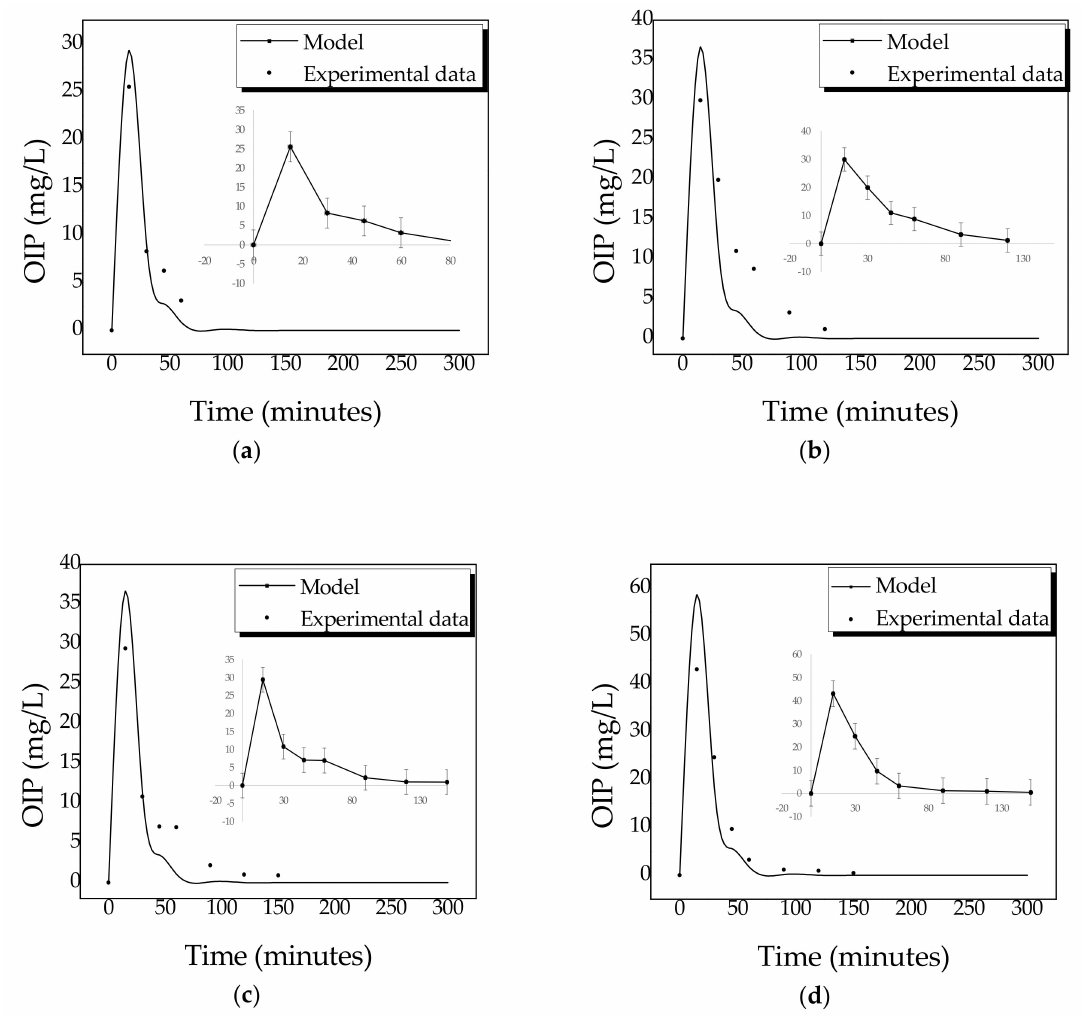
Figure 7. Profile of the generation and consumption of OIPs showing the curve generated by the model and experimental data obtained by a carbon-based mass balance at di ff erent initial concentrations: ( a ) 80 mg / L, ( b ) 100 mg / L, ( c ) 120 mg / L, and ( d ) 160 mg / L. In each case, the error graph is attached and related to the model and the experimental data. For ( a ) the absolute error is in the range of 2.282–3.793; for ( b ), the absolute error is in the range of 1.1603–8.6391; for ( c ), the absolute error is in the range of 0.9903–7.2276; and for ( d ), the absolute error is in the range